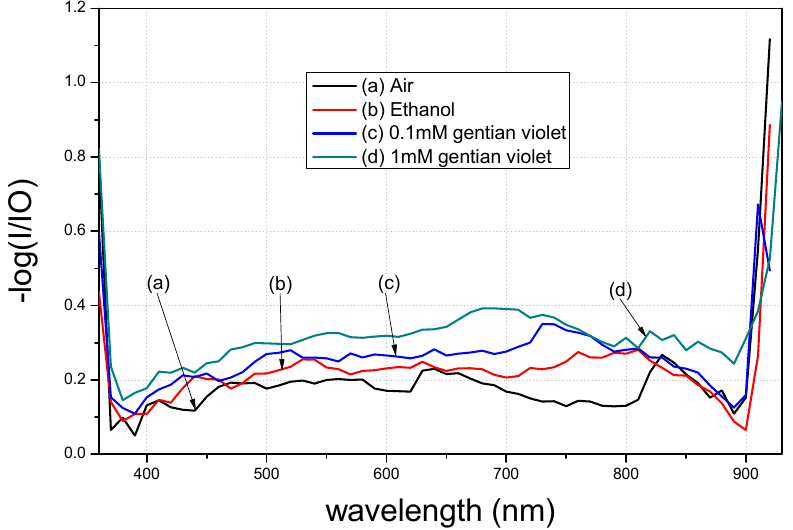
Figure 10. Transmittance of the modified fiber by